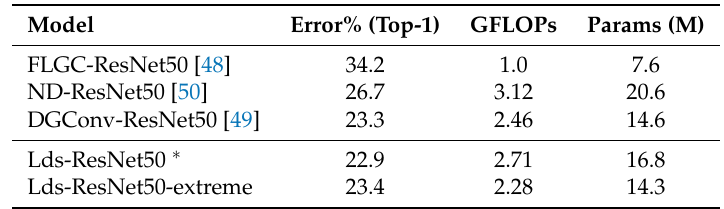
Table 5. The table shows the comparison with similar methods for ResNet50 on ImageNet. ‘ ∗ ’ refers to the LdsConv using the balance